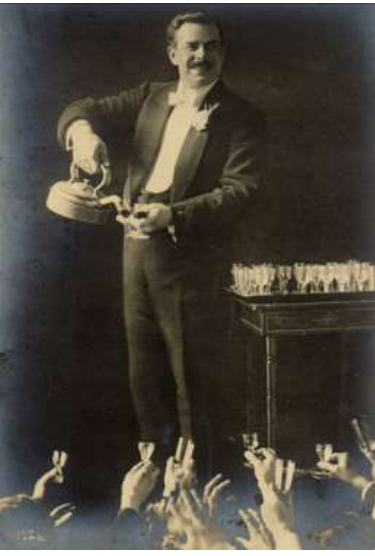
Figure 2. Devant and his Obliging Tea Kettle [36].